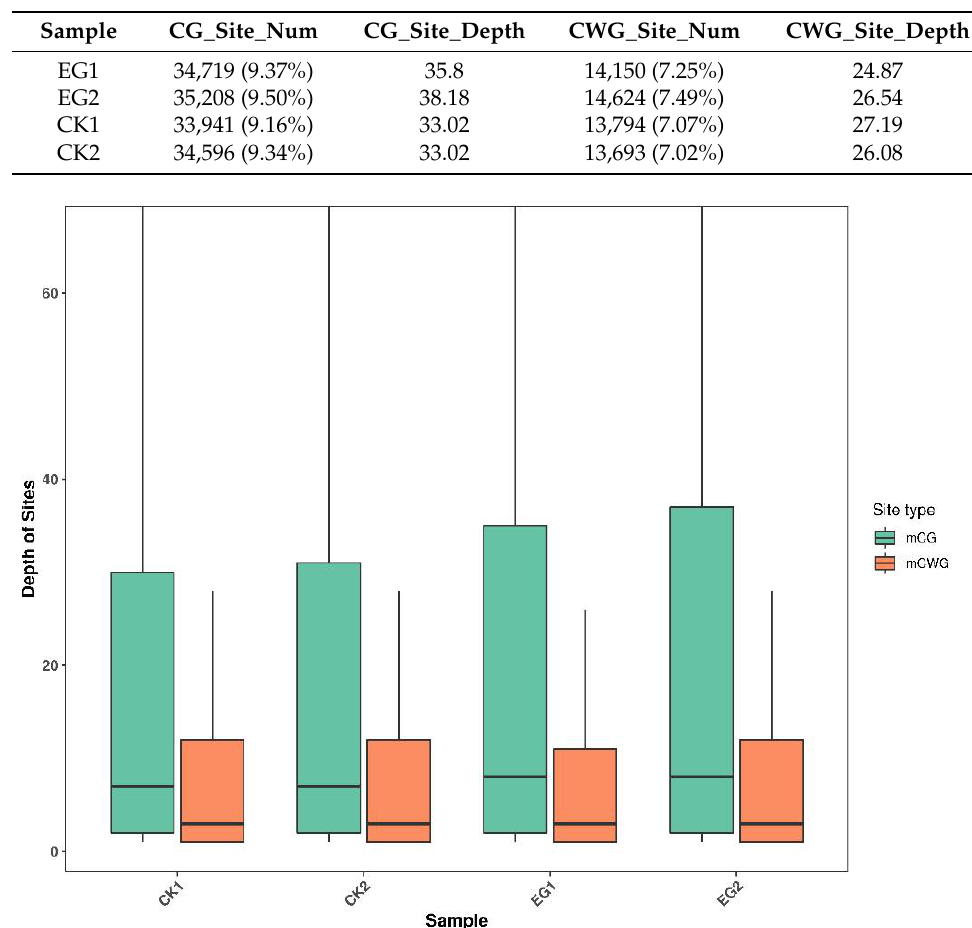
Table 3. Statistics of coverage depth of methylation sites.